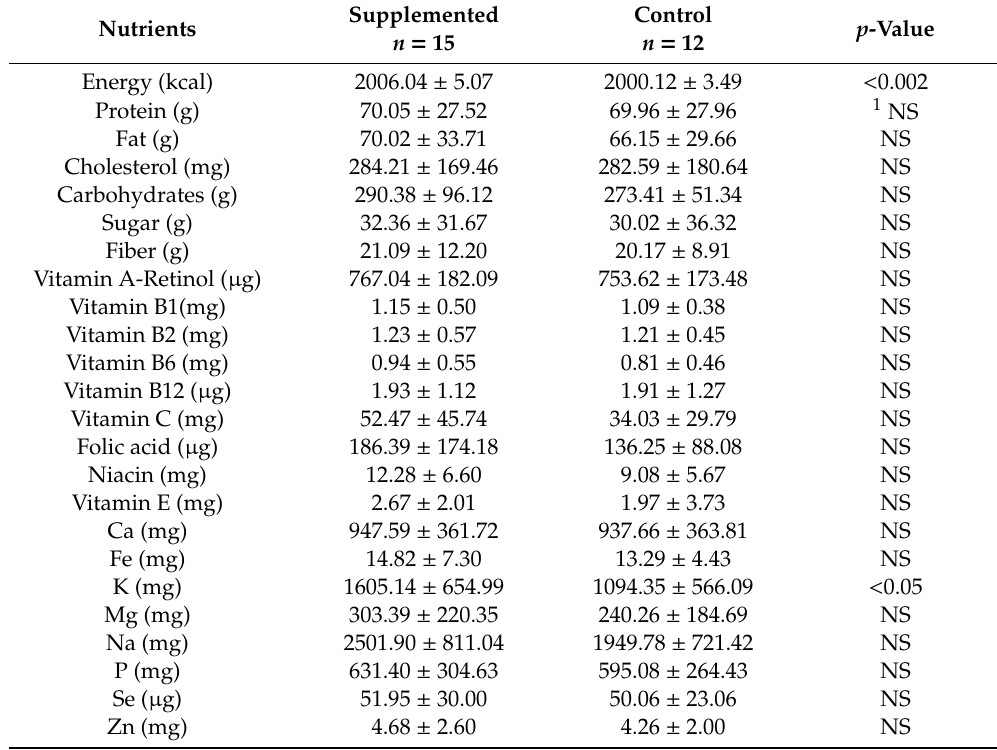
Table 3. Daily intake of energy and nutrients in supplemented and control group.